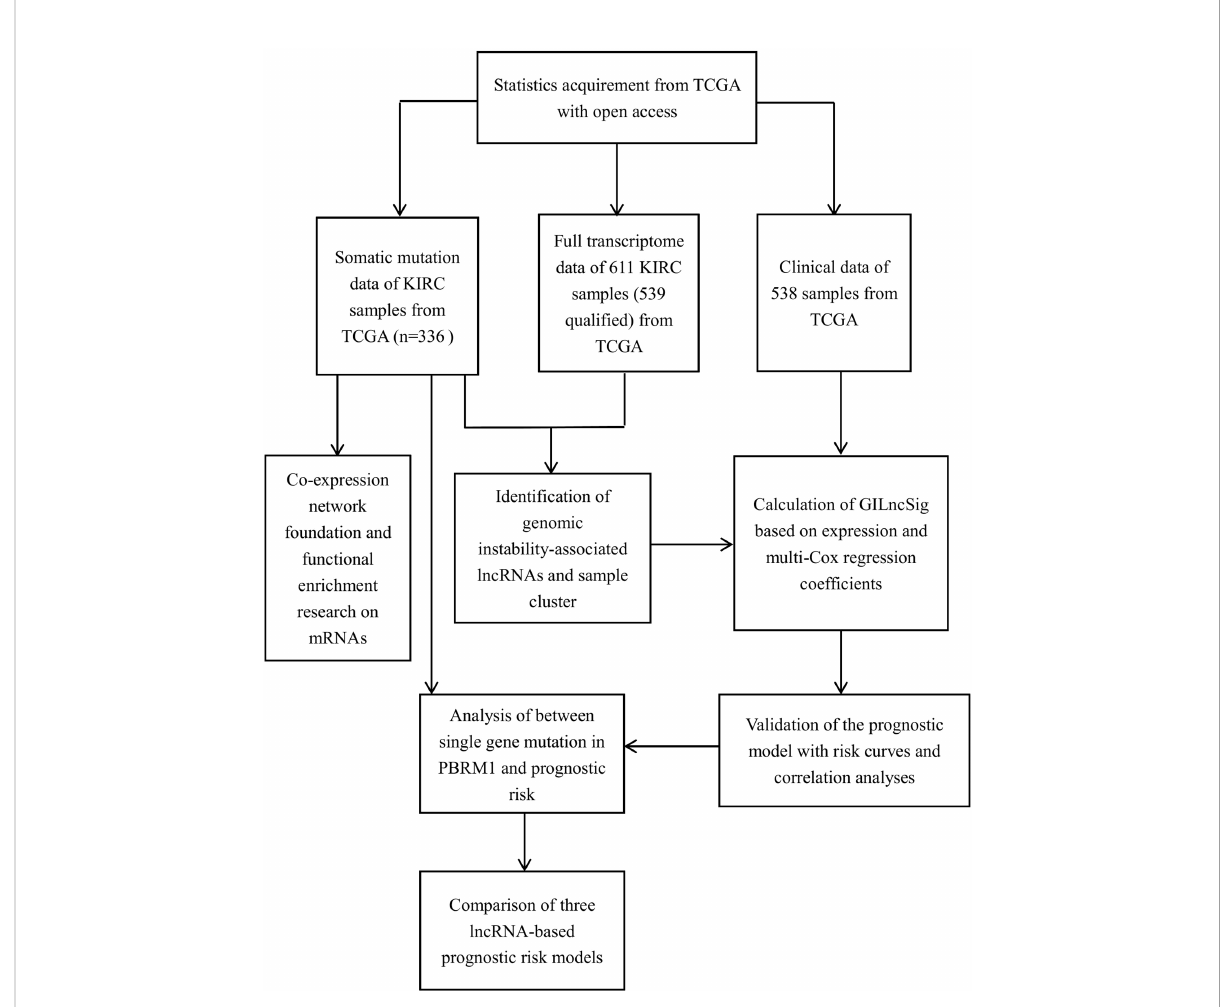
FIGURE 1 The fl ow chart of research